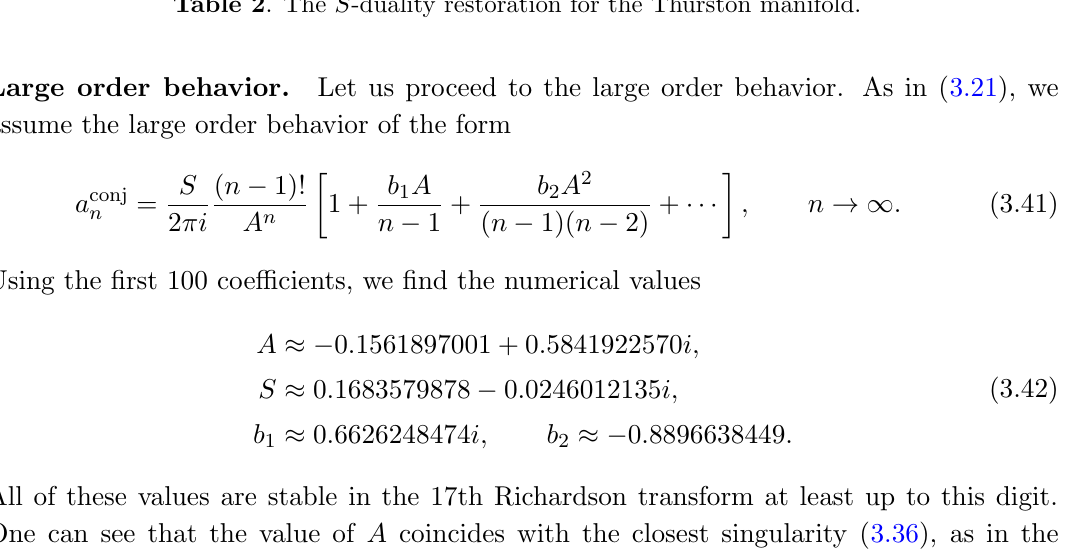
Table 2 . The S -duality restoration for the Thurston